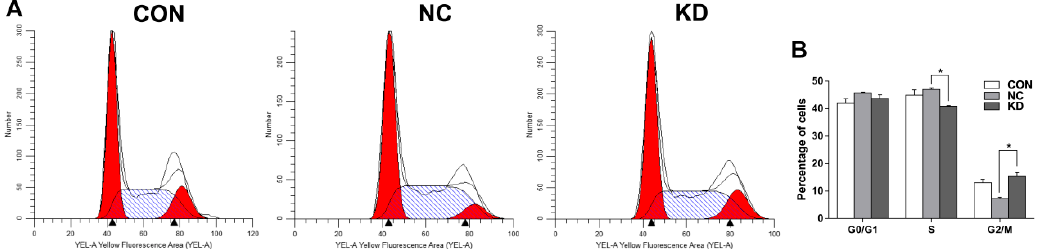
Figure 4. Flow cytometric detection of G2/M phase arrest induced in OL cells following EBLN1 gene silencing. ( A ) Cell cycle distribution of OL cells were determined by using flow cytometry. The left red area is the G0/G1 phase, the right area is the G2/M phase, and the middle strip area is the S phase. ( B ) Knockdown of EBLN1 induces G2/M phase arrest in OL cells. CON, uninfected group; NC, LV-NC-shRNA group; KD, LV-EBLN1-shRNA group. * p < 0.001.